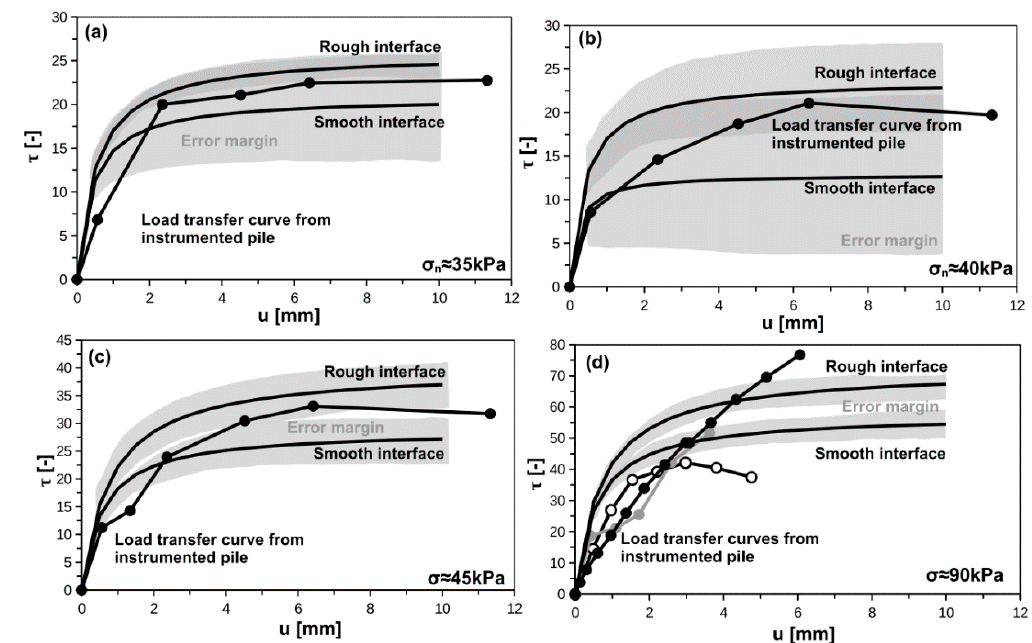
Figure 11. Interface hyperbolic model versus load transfer curves from instrumented pile static loading tests: ( a ) silty loam, ( b ) organic clay, ( c ), peat, ( d ) organic silt.